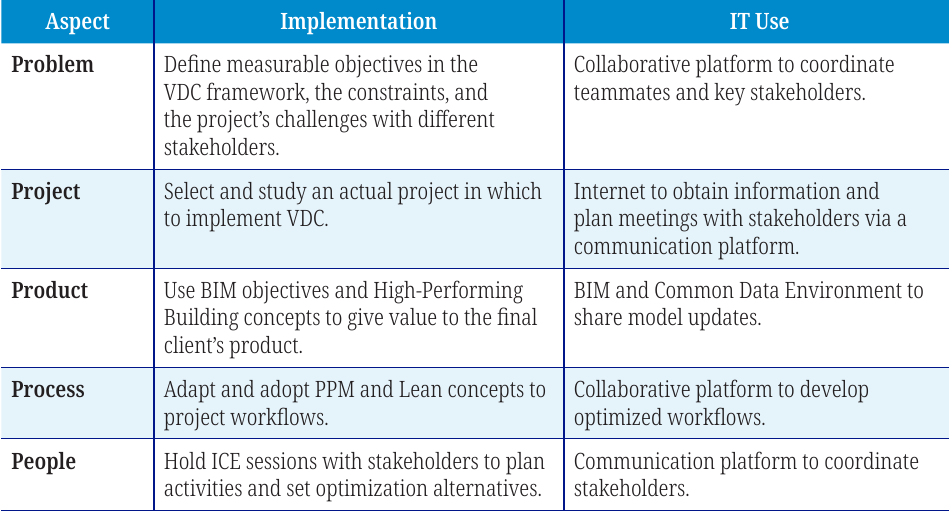
Table 3. Problem-, project-, product-, process-, people-based learning adapted to VDC